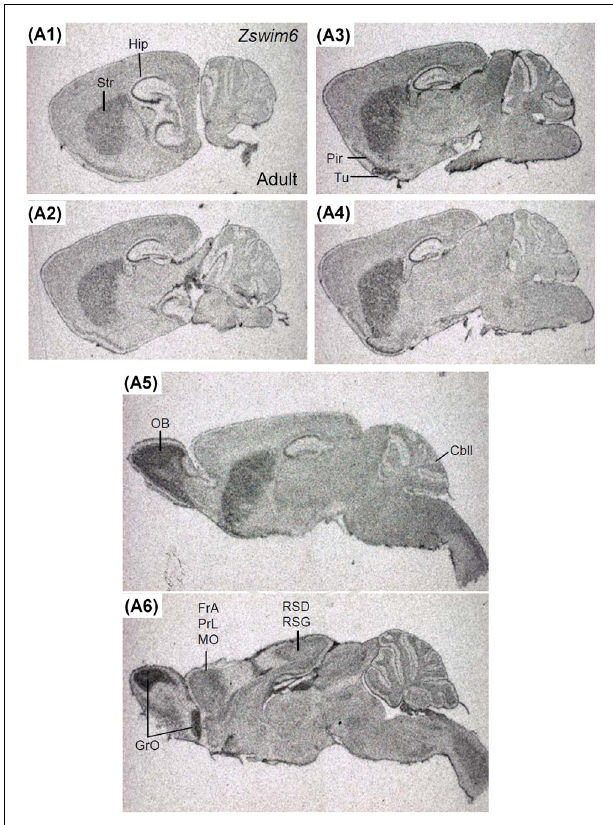
FIGURE 9 | Zswim6 mRNA expression pattern in adult mouse brain. Zswim6 mRNA signals were detected from lateral to medial levels in parasagittal sections of the adult brain (A1–A6) . Cbll, cerebellum; FrA, frontal association cortex; GrO, granular cell layer of the olfactory bulb; Hip, hippocampus; MO, medial orbital cortex; OB, olfactory bulb; Pir, piriform cortex; PrL, prelimbic cortex; RSD, retrosplenial dysgranular cortex; RSG, retrosplenial granular cortex; Str, striatum; Tu, olfactory